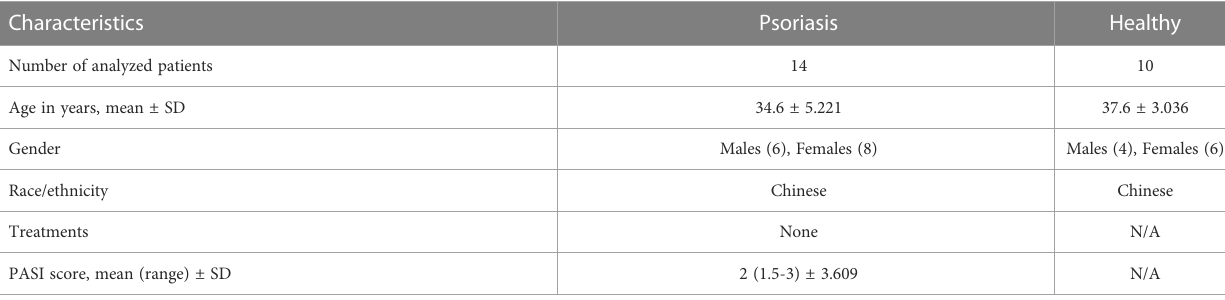
TABLE 2 Characteristics of Psoriasis patients and Healthy controls for detection of MDSCs.